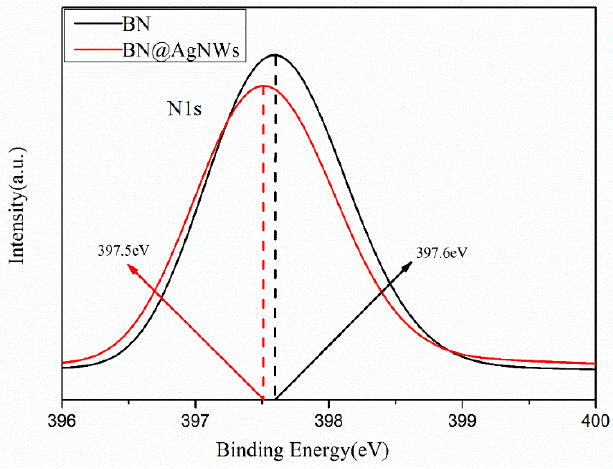
Figure 4. XPS N1s spectra of the BN and BN@AgNWs.